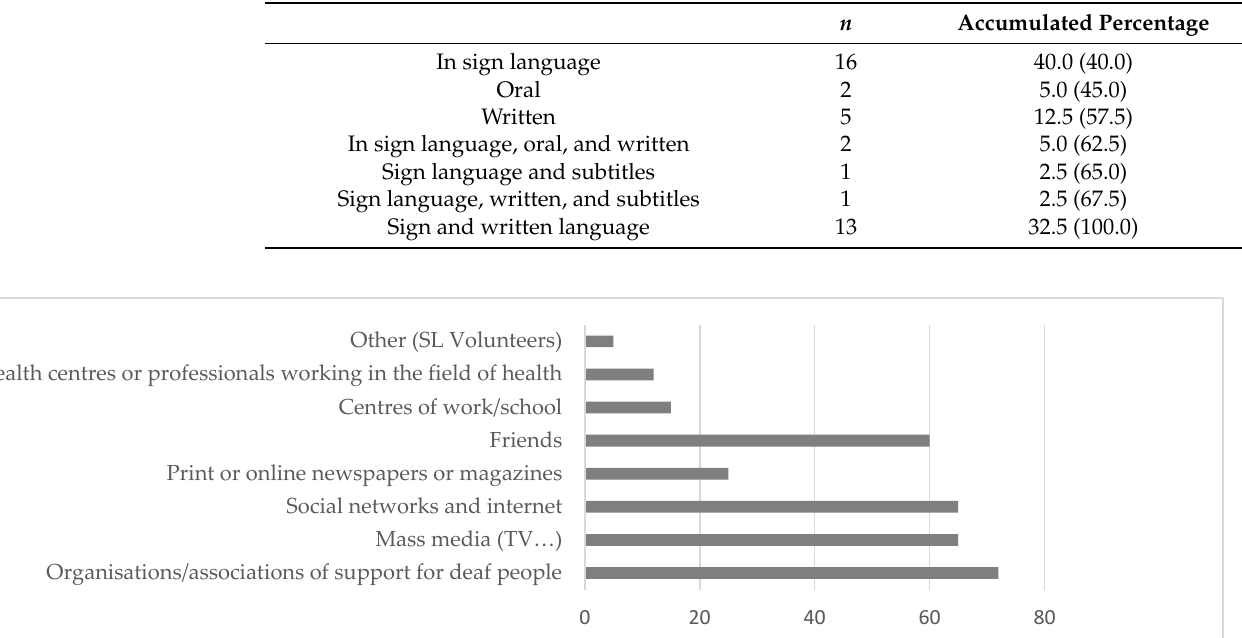
Table 4. Type of information received during the time of the pandemic.